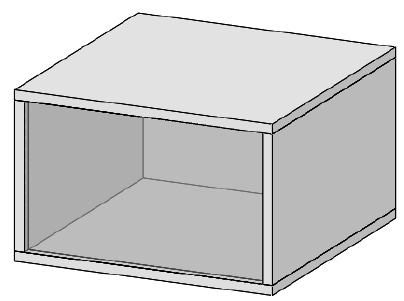
Figure 4. Model of the temperature-controlled box.